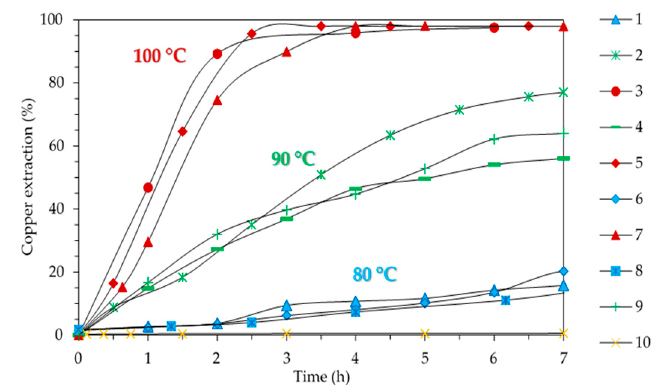
Figure 3. Copper extraction versus leaching time.